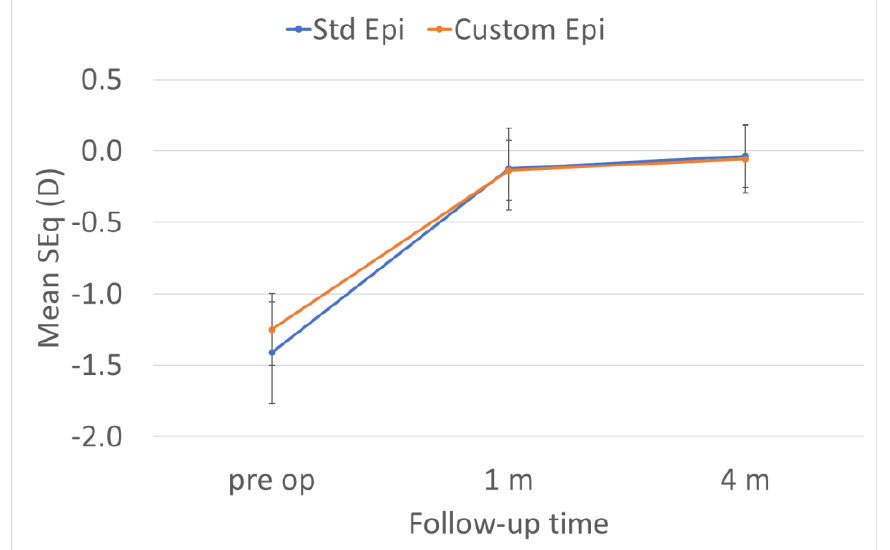
Figure 4. The SEQ did not change in a relevant manner between 1 M and 4 M in either group.